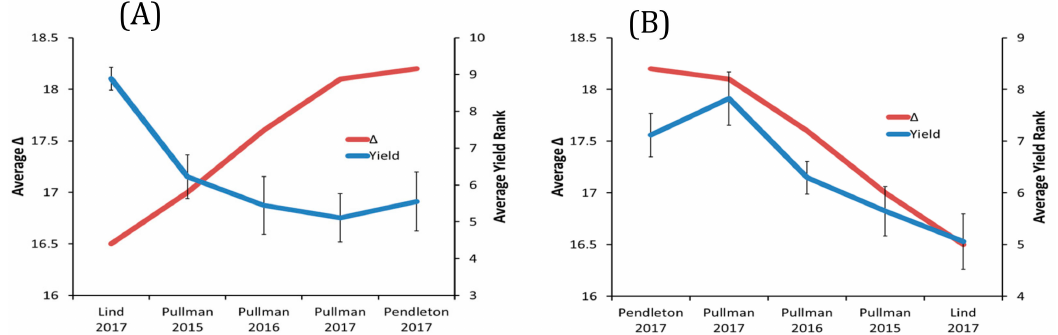
Figure 2. Change in average yield rank of suspected conservative water use genotypes (high yield and low ∆ genotypes from Lind 2017; n = 9) as terminal drought stress (estimated by average ∆ per environment) becomes less severe ( A ). Change in average yield rank of suspected high water use genotypes (high yield and high ∆ genotypes from Pullman 2017 and Pendleton 2017; n = 17) as terminal drought stress (estimated by average ∆ per environment) becomes more severe ( B